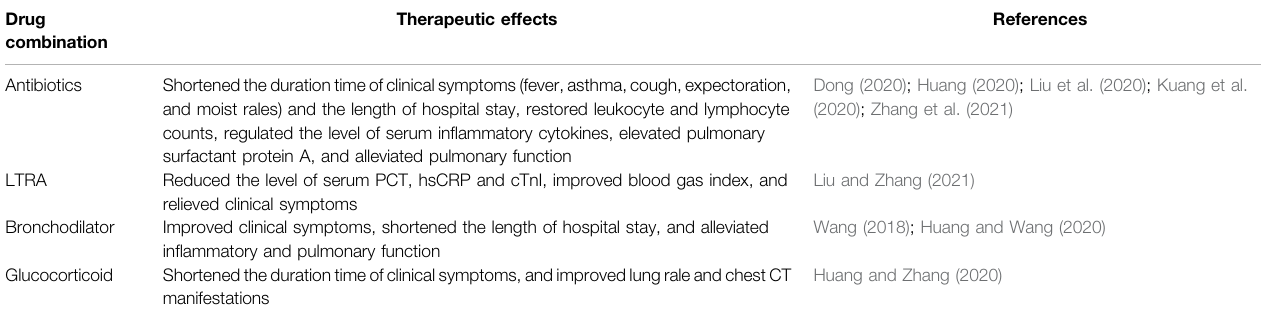
TABLE 1 | Ef fi cacy evaluation of FLKM treatment in patients with